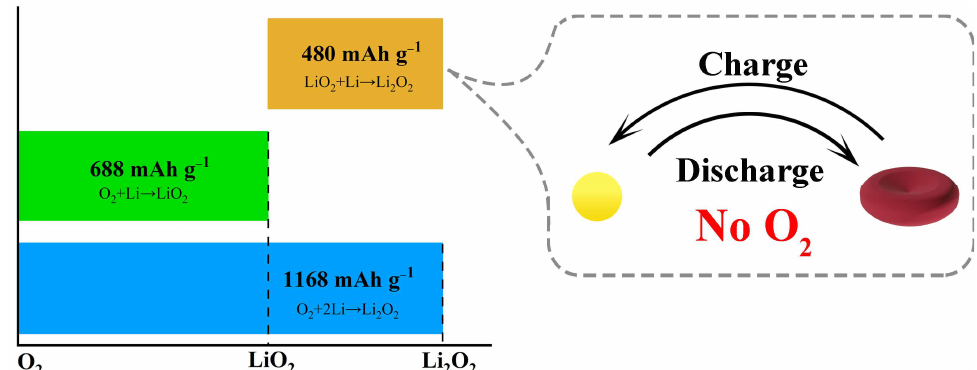
Figure 6. Batteries have two different stages of discharge products: LiO 2 and Li 2 O 2 . The conversion from LiO 2 to Li 2 O 2 does not require O 2 . This can realize the reversible cycle of a closed battery with a capacity of 480 mAh g −1 .